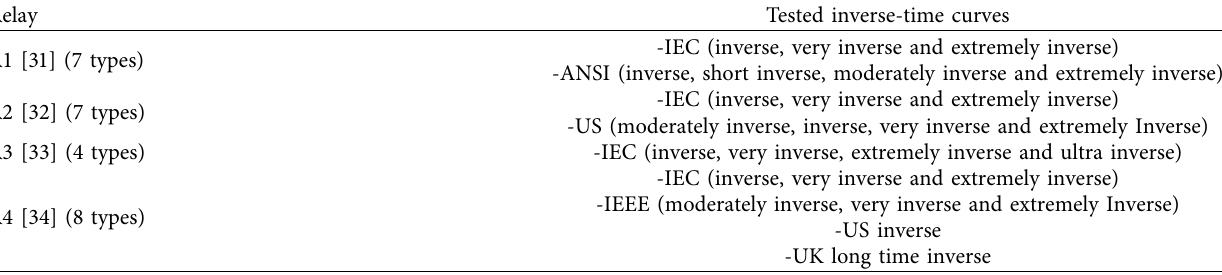
Table 1: Tested inverse-time curves for each relay.